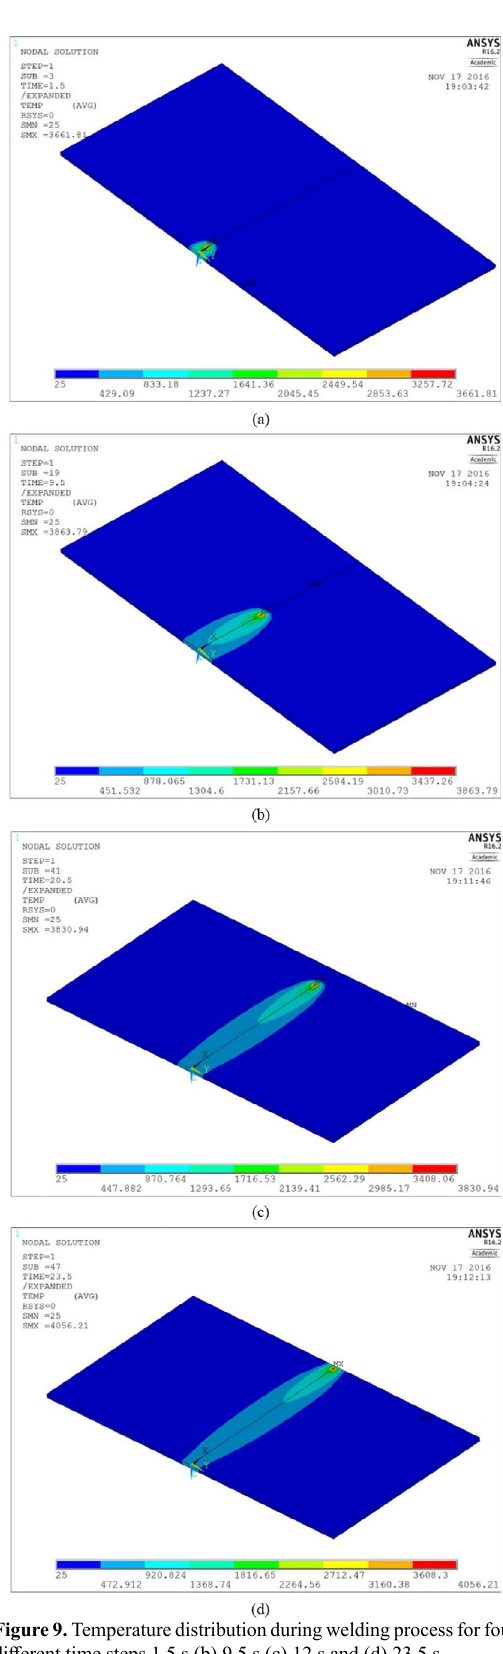
Figure 11. Residual stress distribution in transverse